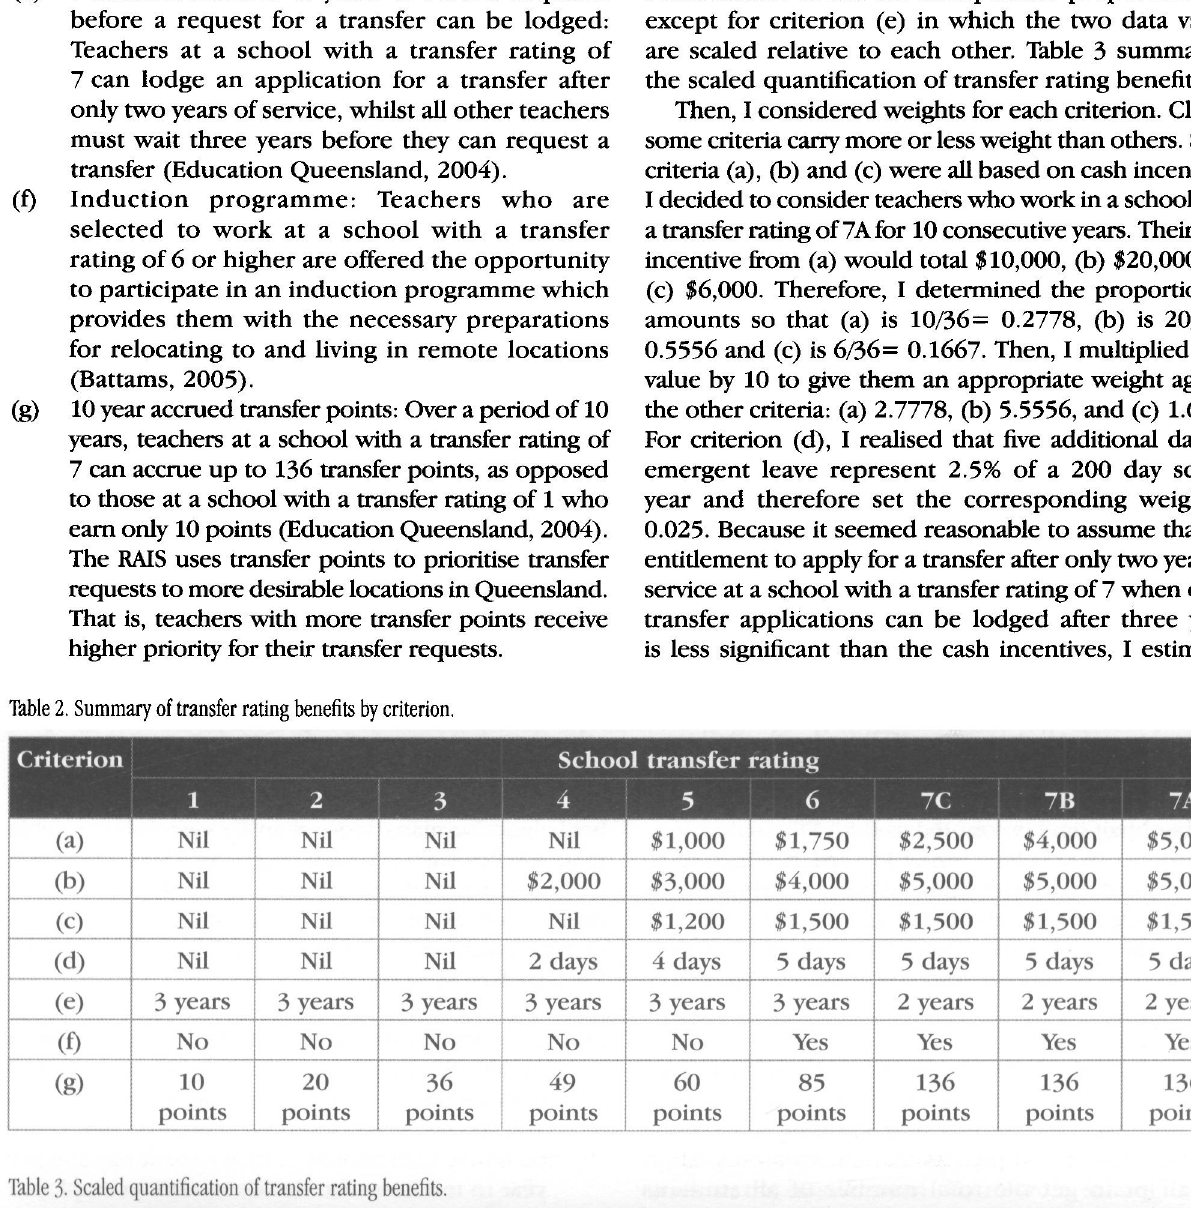
Table 3. Scaled quantification of transfer